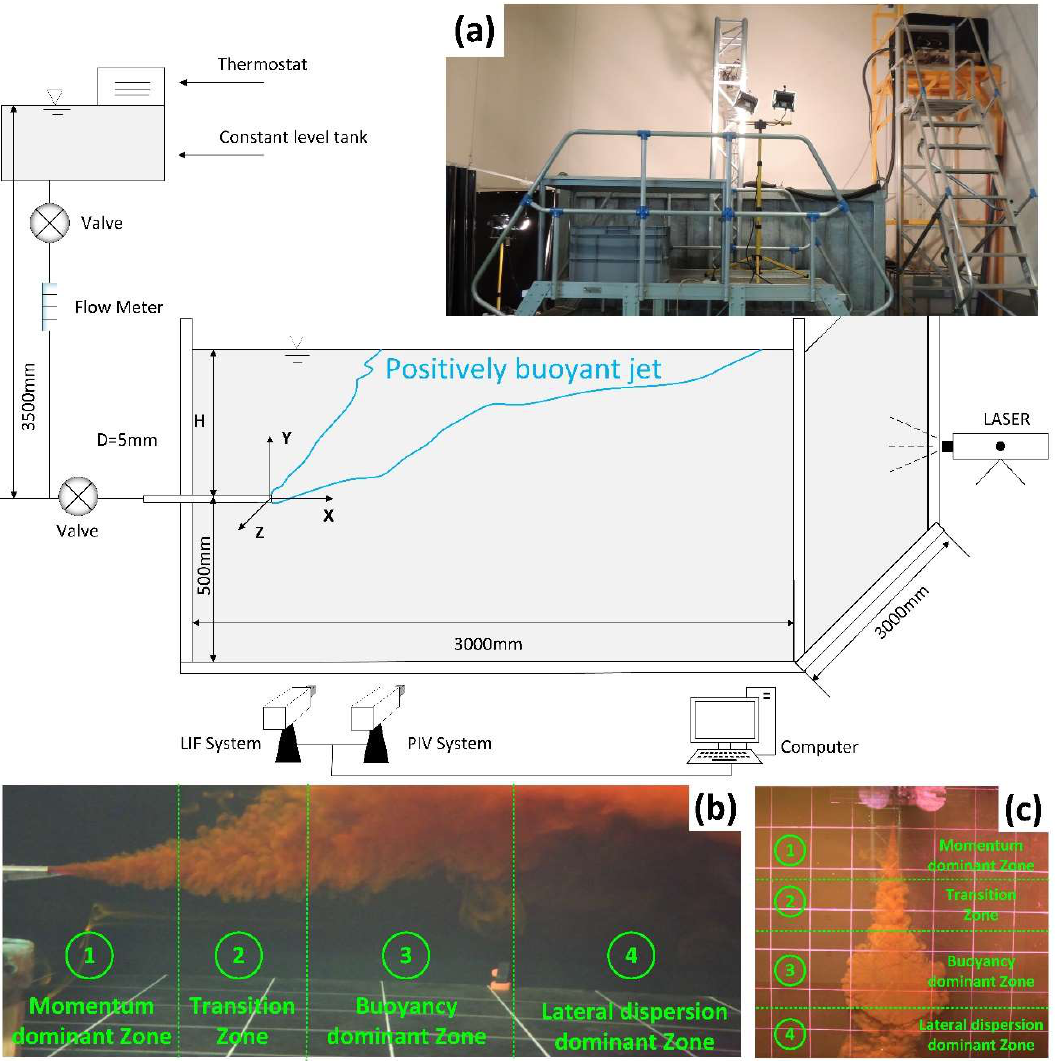
Figure 1. Schematic diagram and photography of the physical model ( a ), profile view of a preliminary test ( b ), and plane view of a preliminary test ( c ).